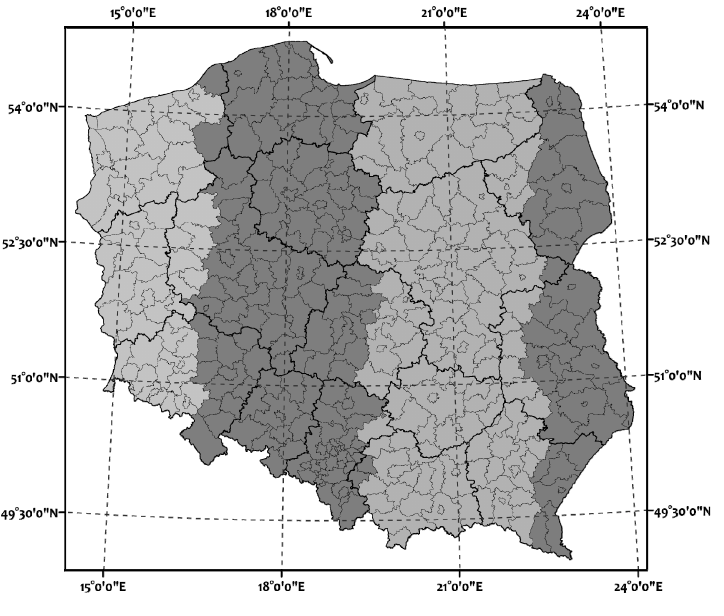
Figure 4. Longitudinal zones of the PL-2000 coordinate system.